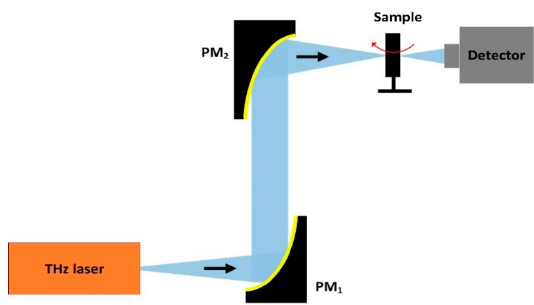
Figure 12. Schematic of the THz-computed tomography (CT) imaging